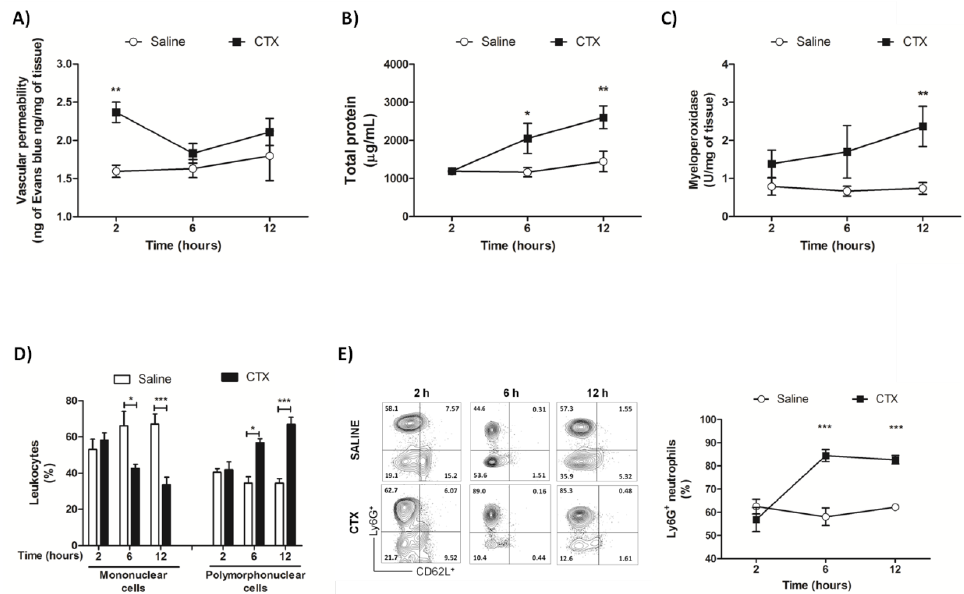
Figure 3. Lung alterations detected in lung homogenates from CTX-treated mice. The animals were treated with CTX (300 µg/Kg s.c.) for 2, 6, and 12 h, euthanized, and their lungs were removed and homogenized for the assays. ( A ) Vascular permeability was evaluated by injecting Evans blue solution 30 min before euthanasia. ( B ) Total protein concentration. ( C ) Myeloperoxidase activity. ( D ) Differential leukocyte counting from cytospin smears. ( E ) Flow cytometry data are summarized in the representative contour plots and line plots showing kinetics of increase of Ly6G + cells. The results from ( A – C ) are representative from two independent experiments ( n = 6 – 7 animals/group), while the results from ( D – E ) are representative from one independent experiment ( n = 5 animals/group). * P < 0.05 , ** P < 0.01 , and *** P < 0.001 vs. saline-treated animals (control) from the respective time